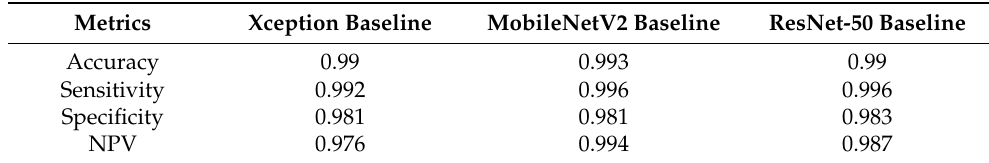
Table 2. Model evaluation performance using classification metrics, namely, accuracy, sensitivity, specificity, and